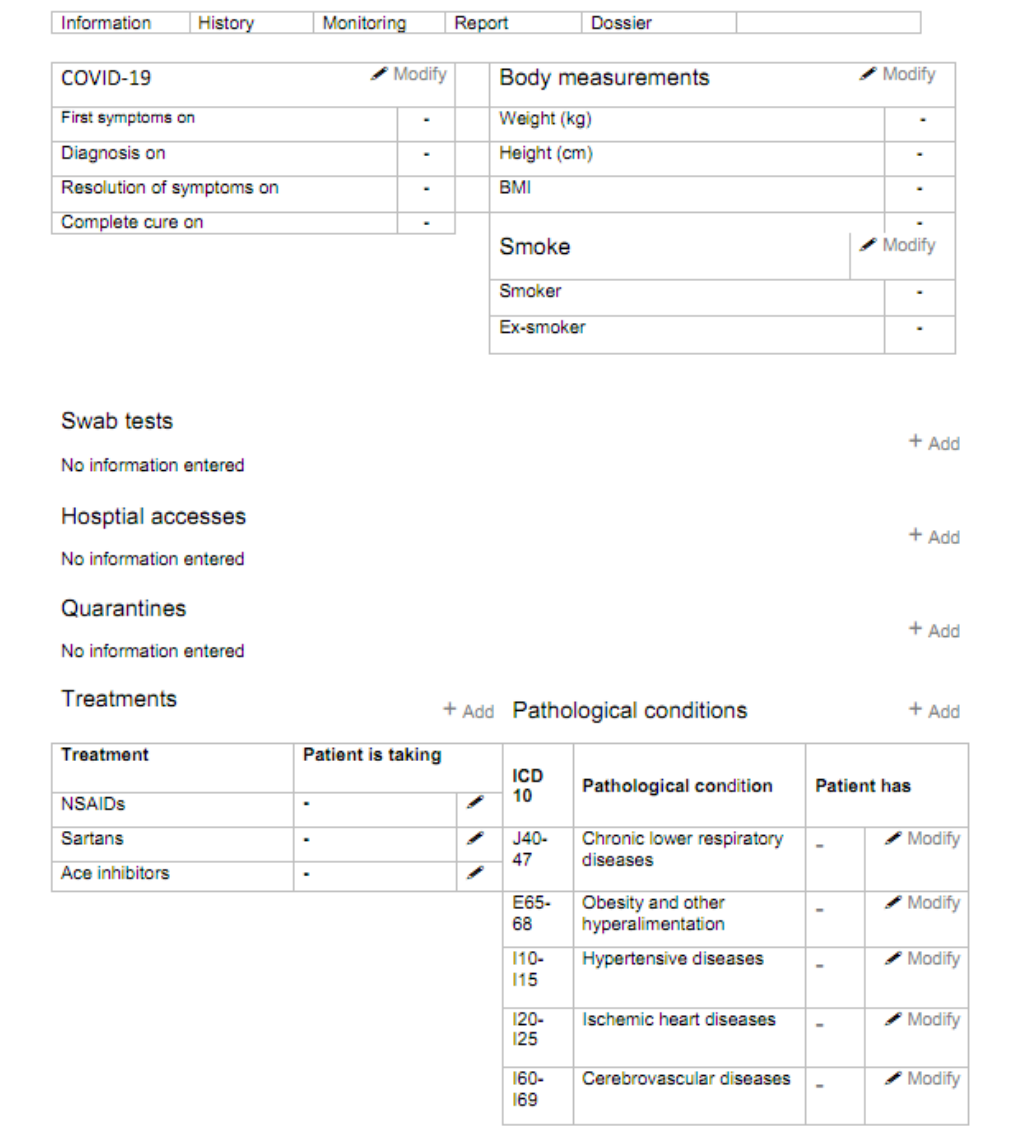
Figure 4. Patient history form.